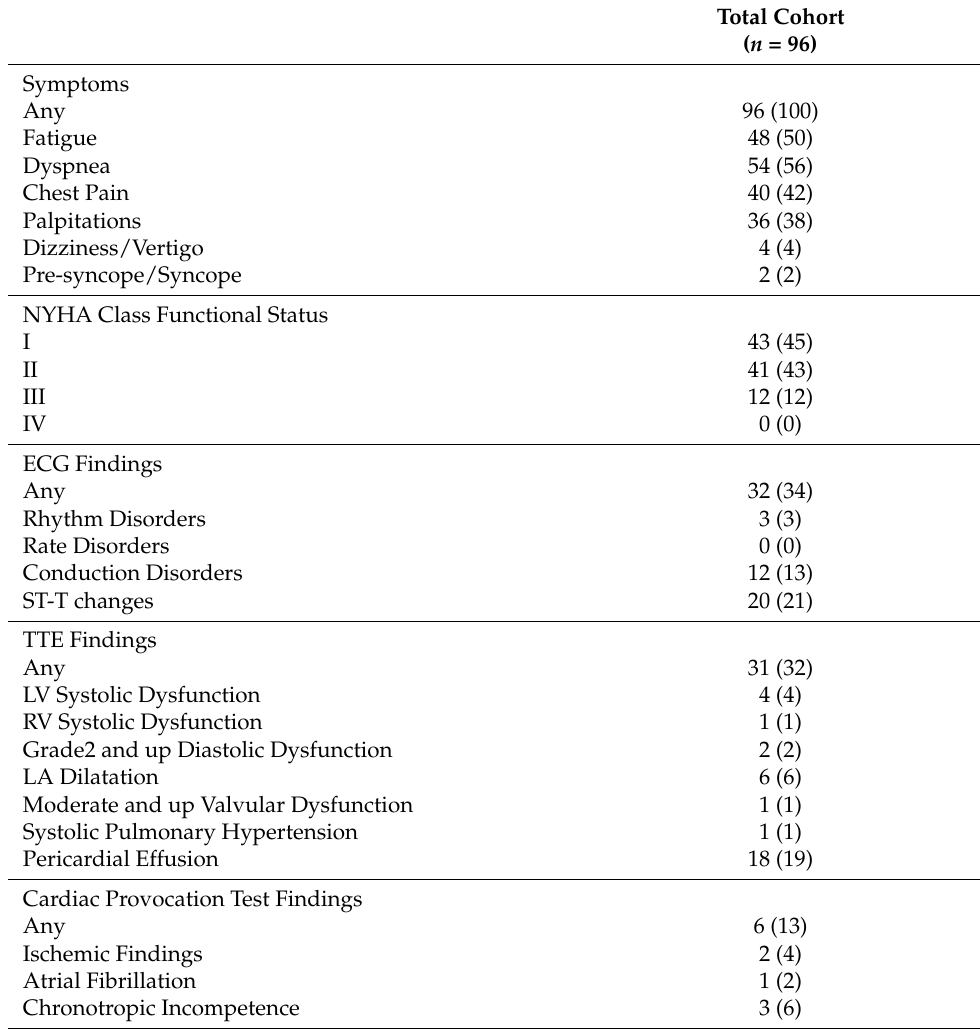
Table 2. Long-COVID symptoms and objective